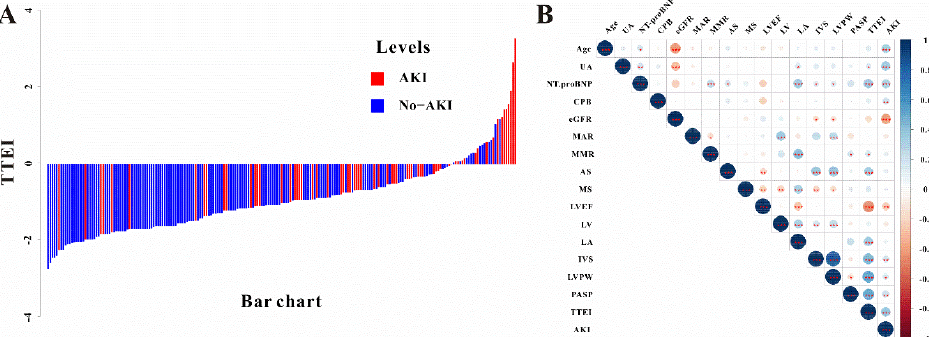
of TTE as well as clinical factors.